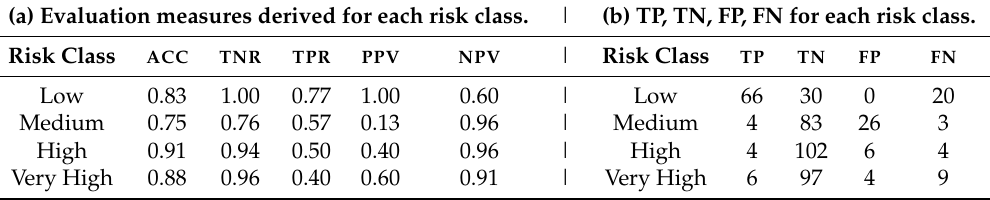
Table 6. Classification